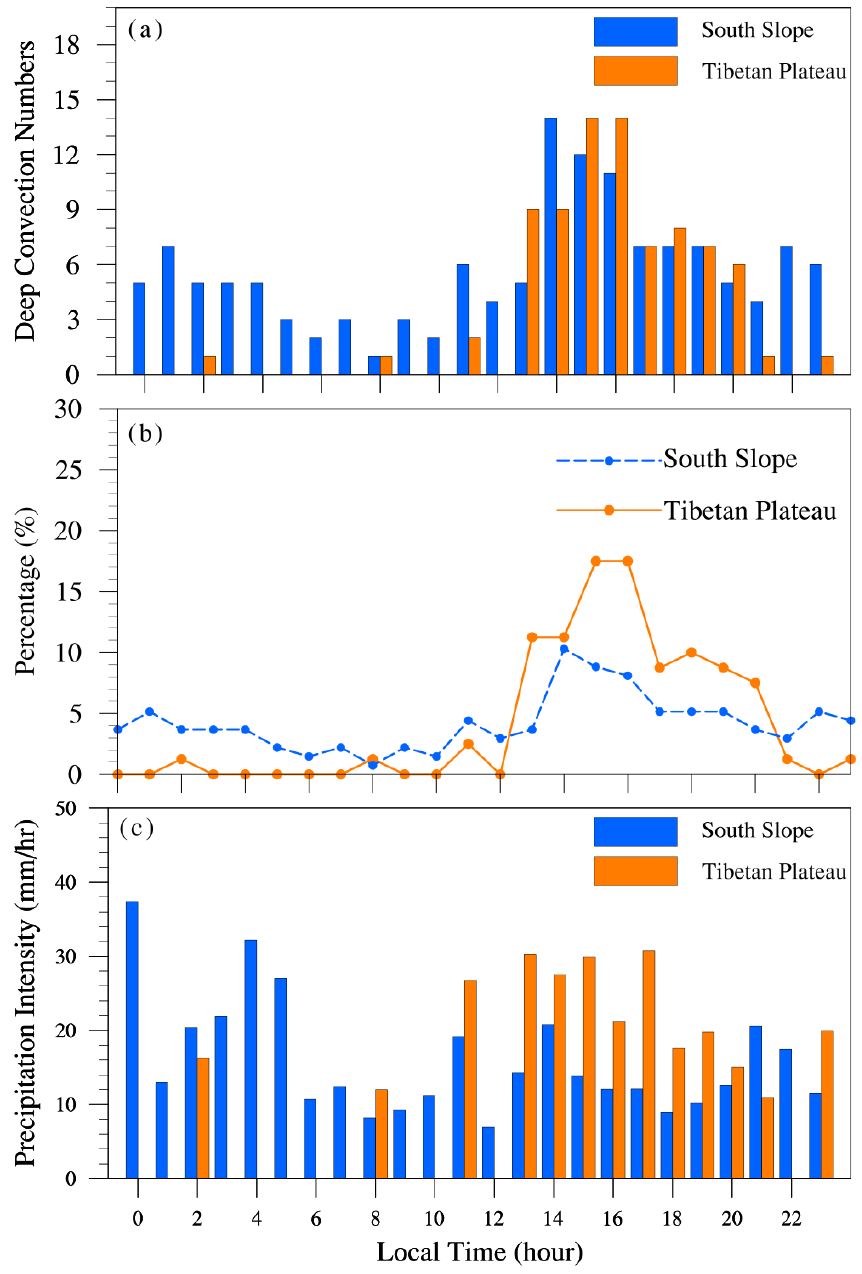
Figure 8. Diurnal variation in DCSs. ( a ) Number of DCSs per hour, ( b ) percent of total DCSs observed across the diurnal cycle, and ( c ) mean precipitation intensity.